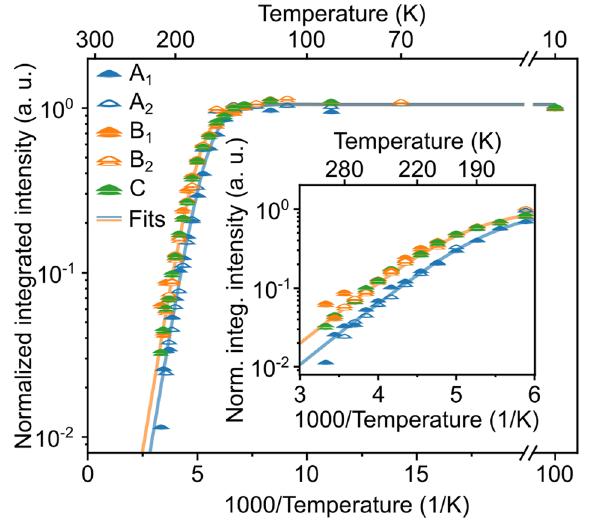
Figure 8. Arrhenius plot of the QD-related signals of two different measurements of the two samples from Fig. 7 and of sample C with a 4 nm thick Si spacer. The PL signals are integrated between 0.8 eV and 1.0 eV and plotted over the investigated temperature range from 10 to 280 K. The inset is a zoom-in of the temperature range between 170 and 300 K. Above 220 K the integrated PL signals of the double-QD samples B and C exceeds the one of the single-QD-sample A by a factor of 2. The solid lines in the inset are fits to the two-level model discussed in the